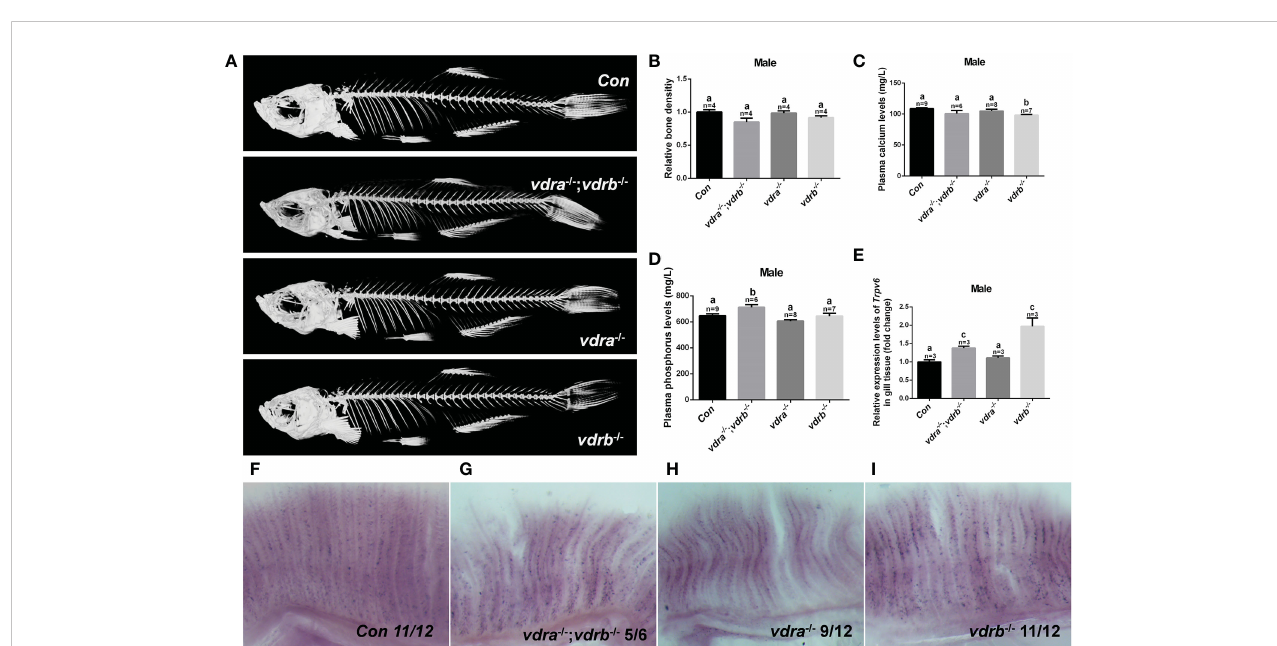
FIGURE 2 The activities of vdra and vdrb are dispensable for the calcium homeostasis and bone development. (A) Micro CT scanning images of mutants and control siblings at 100 dpf; (B) the relative bone density examined using CT scanning. (C) Calcium and (D) phosphorus levels in plasma were measured in mutants and control siblings at 100 dpf; (E) Quantitative real-time PCR assays show the trpv6 transcript levels in the gills of mutants and control siblings at 100 dpf. (F – I) . The trpv6 expression patterns in the gill of the mutant and control. The representative images were selected and the blue-purple dot in the gills was the expression signals. The bars with different letters indicated signi fi cant difference